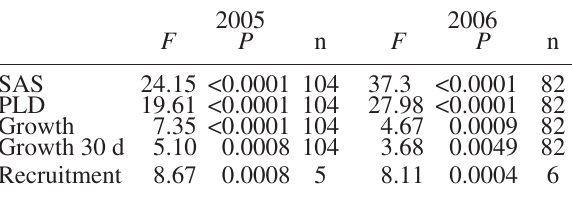
Table 1. – Summary of ANOVA comparing early life history traits and recruitment of Coris julis spanning all sampling dates in two consecutive seasons, 2005 and 2006. n represents the total number of otoliths analyzed per season (first four rows) and number of re- cruitment surveys each year (last row)